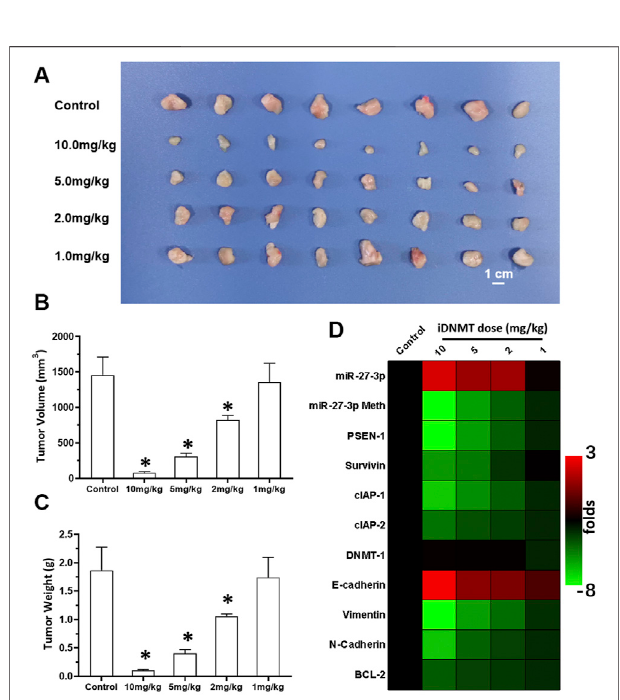
FIGURE 6 | Oral administration of iDNMT inhibits the subcutaneous proliferation of H226 LSCC cells in nude mice. (A) Images of tumor tissues. (B, C) Volumes and weights of tumor tissues are displayed as histograms. (D) Effect of iDNMT on the expression of Notch pathway-related factors is displayed as a heat-map. Comparison between the iDNMT group and control group. * p < 0.05.